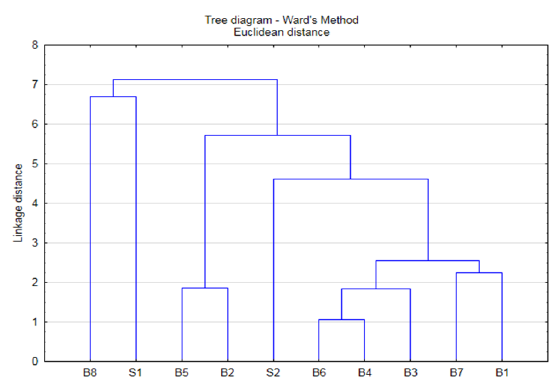
Figure 7. Grouping results in 2017.